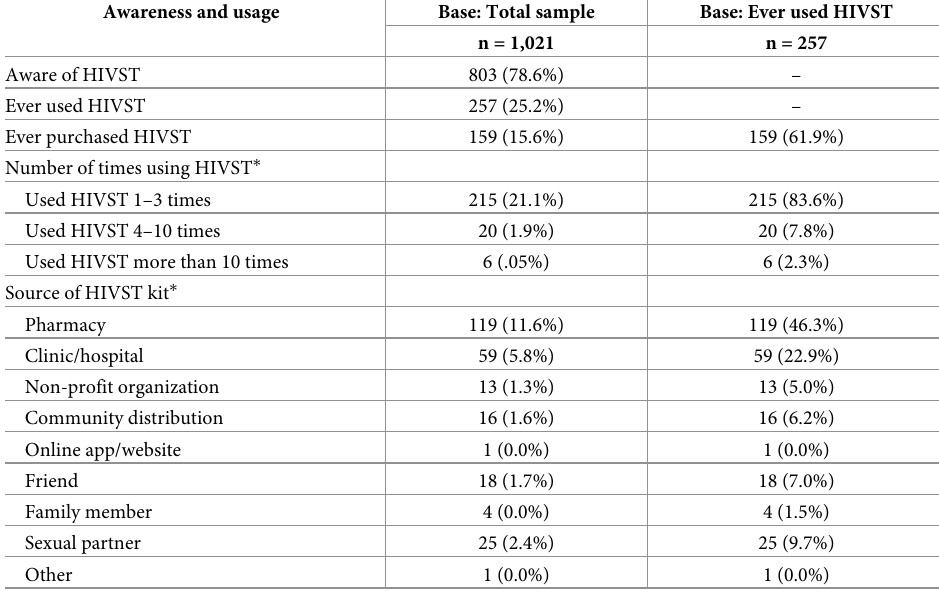
Table 2. HIVST awareness and